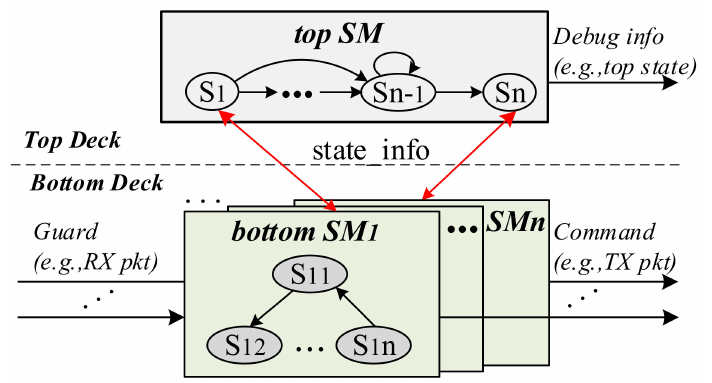
Figure 3. The DoubleDeck model consists of top SM and bottom SMs. SM is an abbreviation of State Machine. The state in the top SM is the externally visible global state. The state in bottom SMs is a local state that is not visible from the